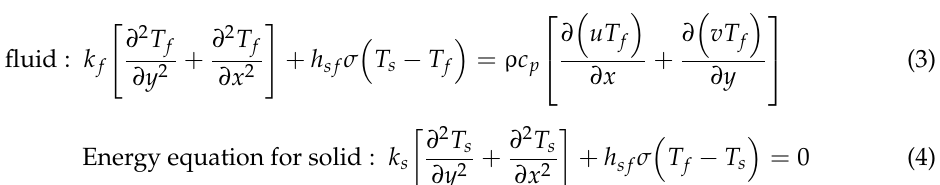
Figure 1. Solution domain for preliminary